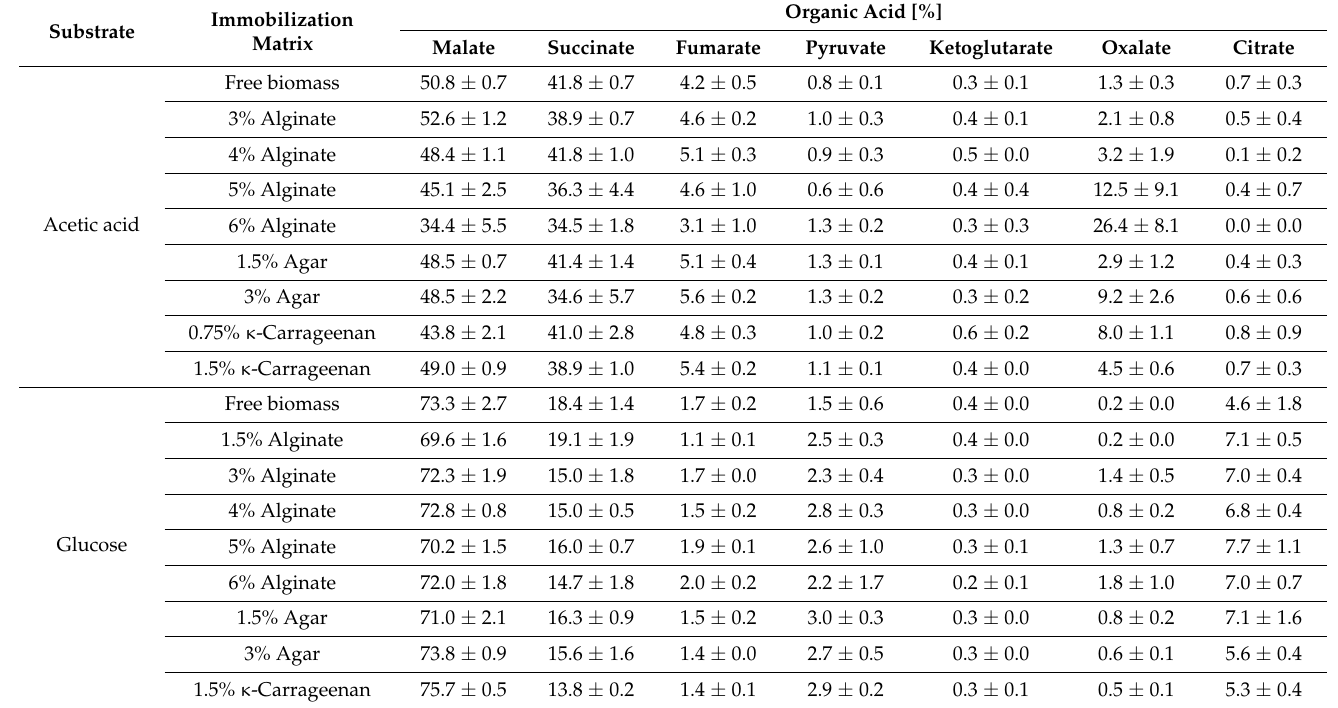
Table A1. Acid distribution for shake flask cultivations of A. oryzae after 144 h. Values are means of triplicates with standard deviation.